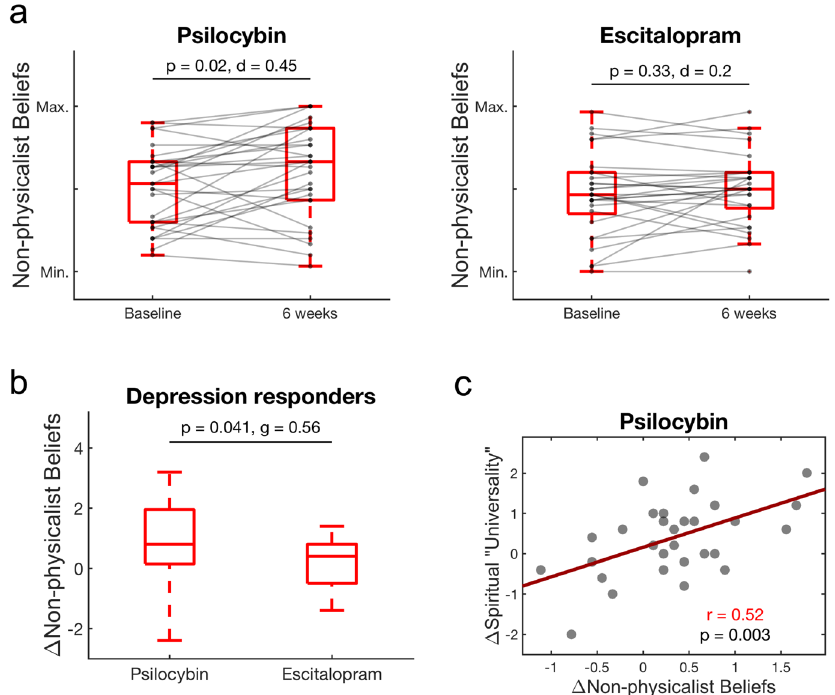
Figure 5. Consistent shifts away from physicalism after psilocybin therapy for depression: ( a ) significant shifts away from hard physicalism were only seen for psilocybin and not the escitalopram condition at the 6 week endpoint versus baseline (Bonferroni-corrected; p values and Cohen’s d effect sizes shown). ( b ) Greater belief-shifts in the predicted direction were found for treatment responders in the psilocybin condition versus responders in the escitalopram group (p value and Hedges’ g effect size shown). ( c ) Shift in non-physicalist beliefs were significantly associated with increases in ‘Spiritual Universality’ (STS scale) at the 6-week